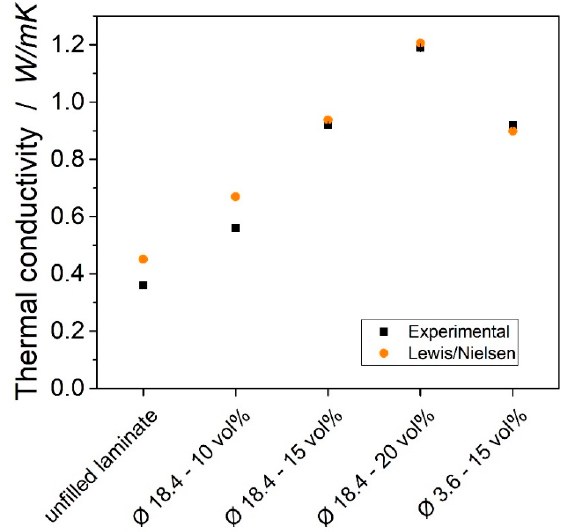
Figure 11. Thermal conductivity of the laminates from the experimental data and calculated according to Lewis/Nielsen equations.